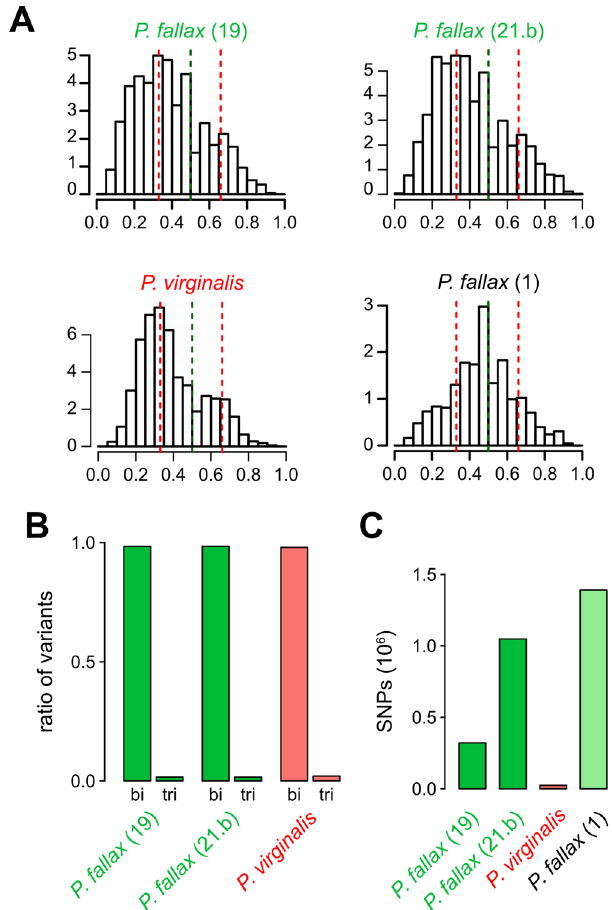
Fig. 3 Triploidy in Procambarus fallax . A Heterozygous allele frequency distribution in two triploid P. fallax , in P. virginalis and a diploid P. fallax . The histograms show the frequencies of heterozygous alternative allele ratios. Numbers for allele frequencies are indicated as counts (in 10 5 ). B Distribution of biallelic (bi) and triallelic (tri) SNPs in P. virginalis and in triploid P. fallax . C Numbers of biallelic SNPs, relative to the P. virginalis reference